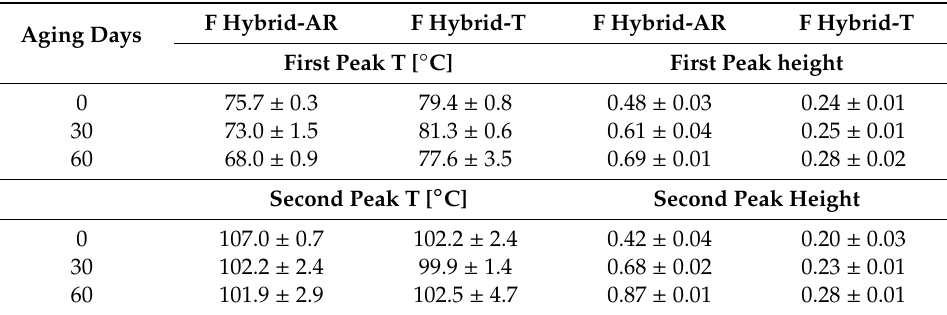
Figure 6. ( a , b ) Typical storage modulus and ( c , d ) tan δ trends of F-Hybrid composites in each Figure 6. ( a ) ‐ ( b ) Typical storage modulus and ( c ) ‐ ( d ) tan δ trends of F ‐ Hybrid composites in each aging condition. aging condition. Table 4. Damping properties of F Hybrid composites for each aging condition. Table 4. Damping properties of F Hybrid composites for each aging